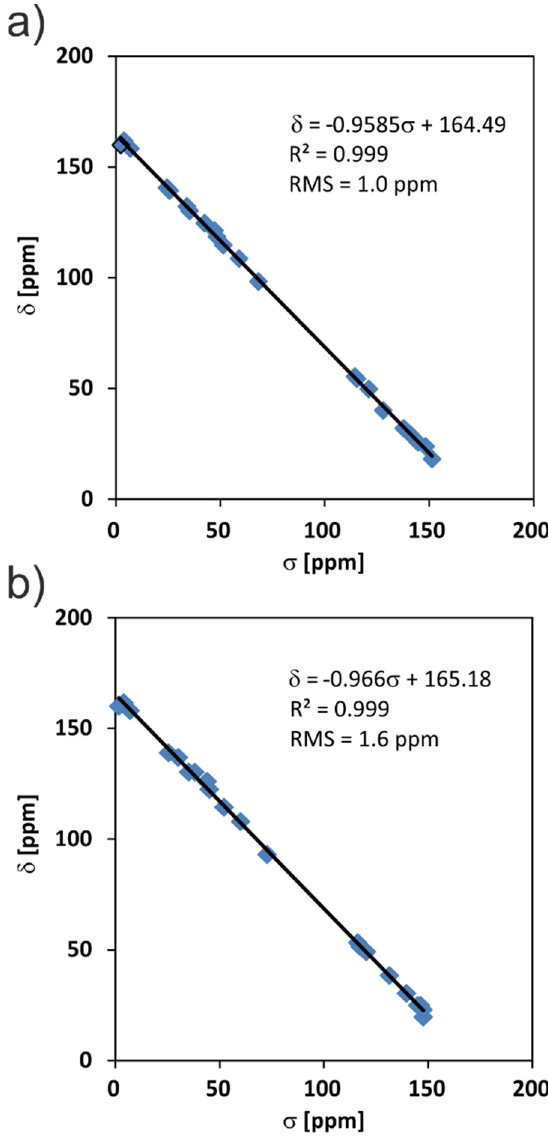
Figure 9. The correlation of experimental 13 C chemical shift values ( δ ) and calculated nuclear shielding ( σ ) values of the MBS ( a ) and MBS HCl ( b ).